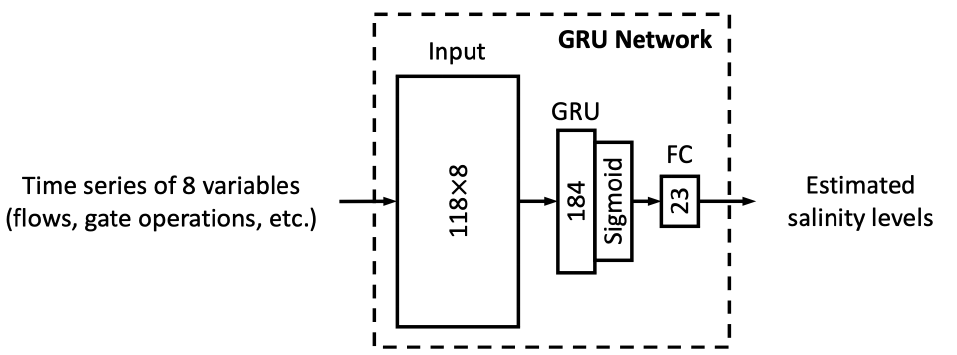
Figure A4. Diagram of the GRU network from [29]. The number in the input layer denotes input shape and those in the subsequent layers represent the numbers of units/neurons of the layers.